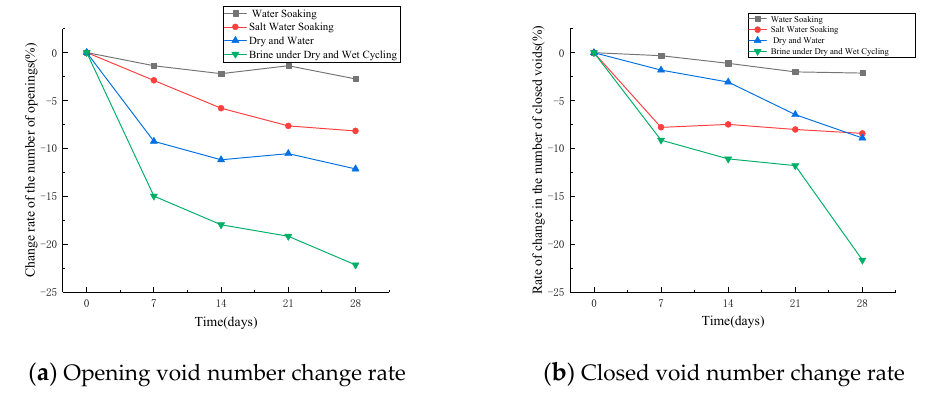
Figure 13. Change rate of voids in asphalt mixture.